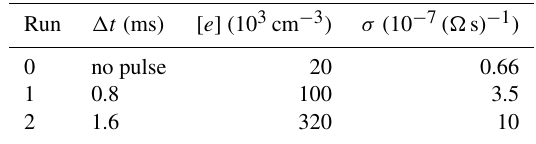
Table 3. Parameters of the electric field pulse in streamer trailing column at 75km. (cid:49)t is the pulse duration, [ e ] the peak electron density, and σ the peak conductivity.